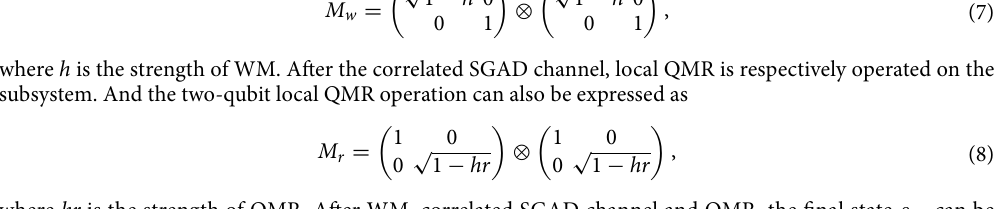
Figure 4. (Color online) Effect of squeezing degree m on the decay of nonlocal quantum correlations when n 1 . ( a ) The effect of m on quantum entanglement when µ µ = = of decoherence time t for different m . ( c ) The evolution of Concurrence C under completely correlated AD n 1, m 0 ), GAD ( µ 1, m 0, n 1 ) and SGAD ( µ ( µ = = = = = = parameters B as a function of decoherence time t for different m . ( e ) Critical radii R AB and R BA are a function of decoherence time t for different m . ( f ) The enlarged view of Fig. 4e when t R BA denotes the time when R AB =